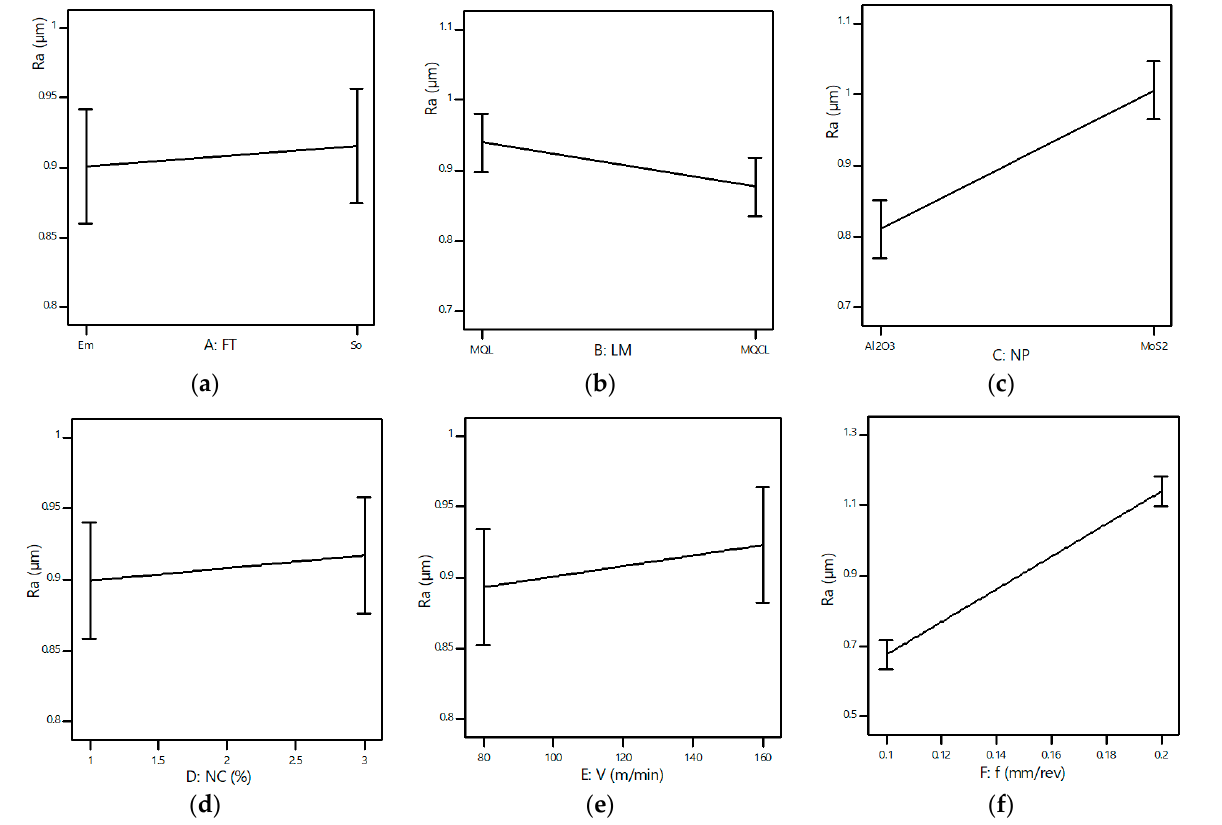
Figure 6. The main effects of input parameters: ( a )—FT; ( b )—LM; ( c )—NP; ( d )—NC (%); ( e )—V(m/min); ( f )—f(mm/rev).